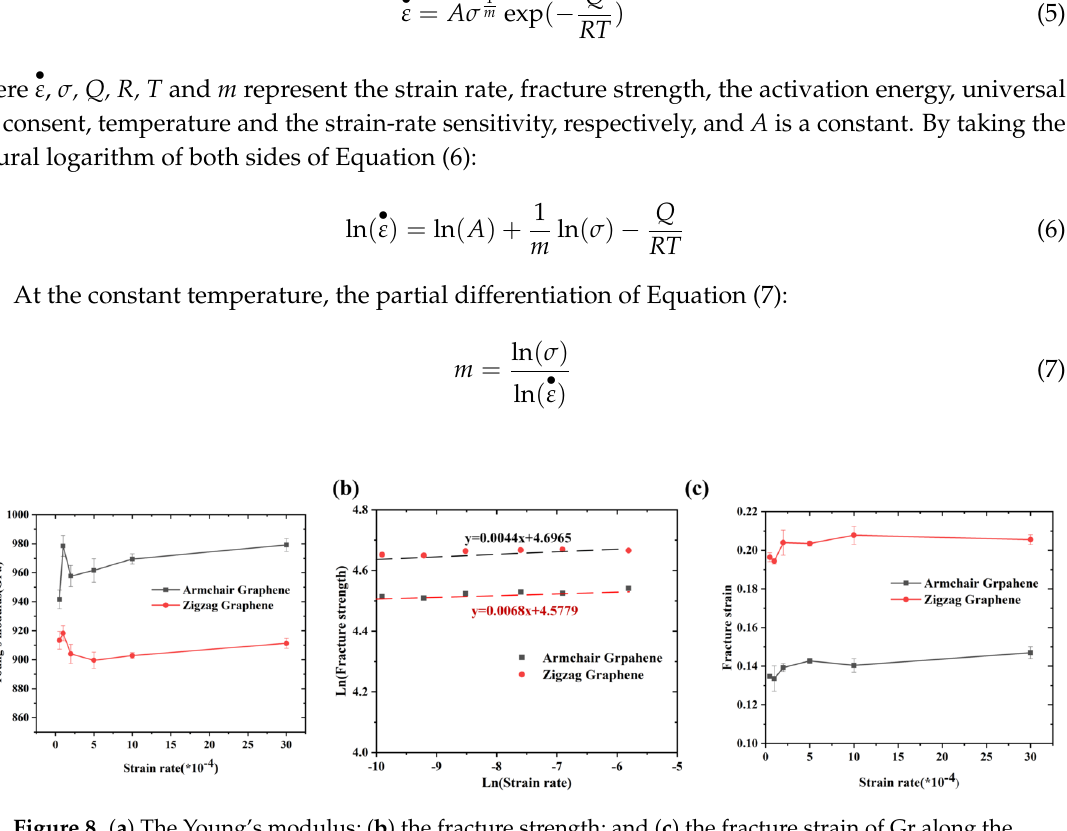
Figure 7. ( a ) The Young’s modulus; ( b ) the fracture strength; and ( c ) the fracture strain of Gr along the armchair and zigzag directions at different temperatures.